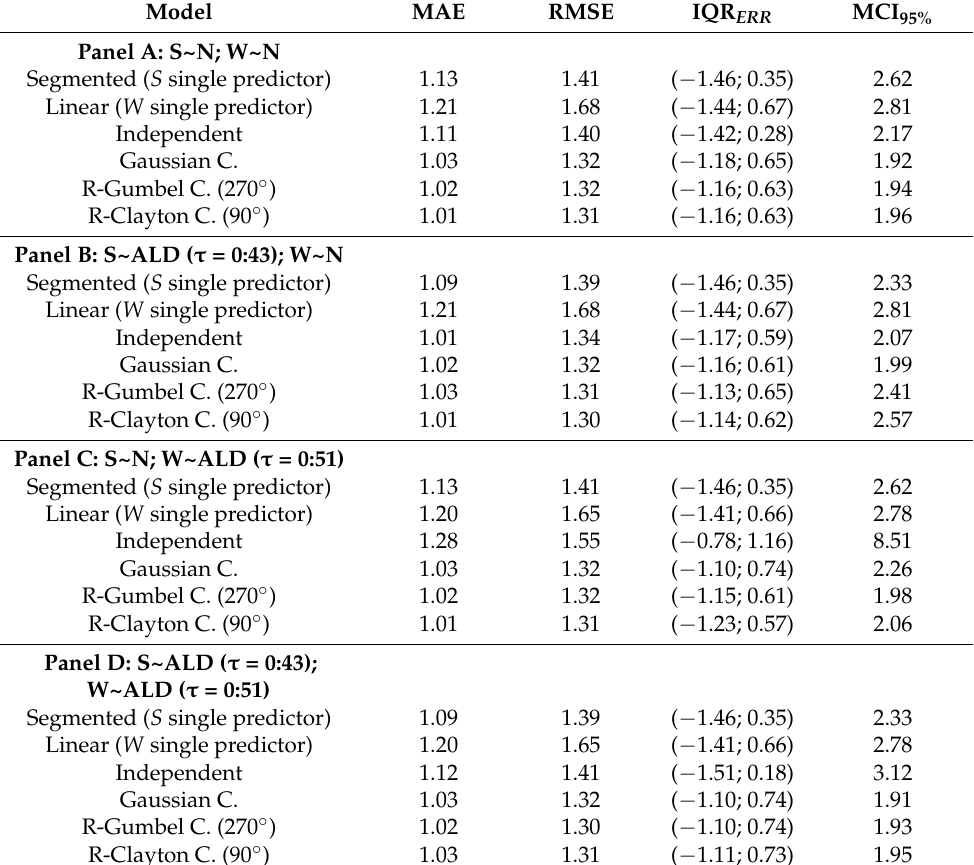
Table 2. Prediction comparison of the considered models with observed data (validation